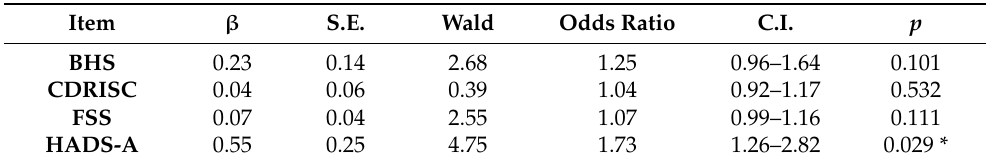
Table 3. Associated factors of depressive disorder among patients at the 12-month follow-up: lo- Table 4. Associated factors of depressive disorder among caregivers at the 12-month follow-up: gistic regression analysis. logistic regression